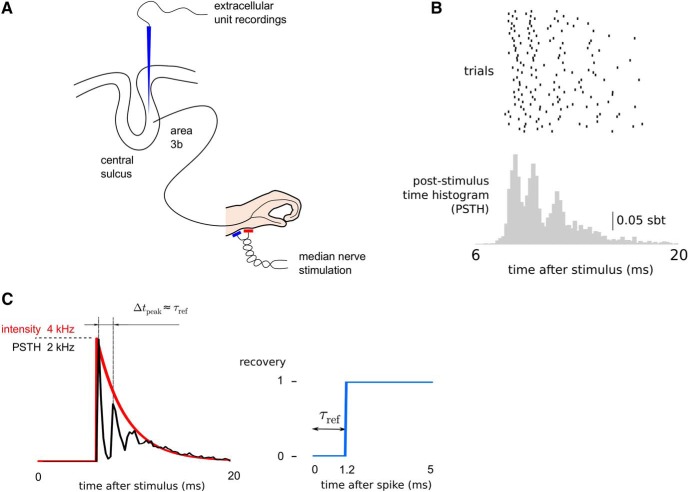
Modeling responses to median nerves stimulation of neurons recorded in S1 of macaque monkeys. A, Sketch of the experimental paradigm. B, Raster plot of 60-sample responses of a single neuron (top) and the PSTH calculated from all 956 trials (bottom; sbt, spikes per bin per trial, bin size 0.2 ms). C, Simulation of the STPM with sample parameters: exponentially decaying intensity function (left, red line) and recovery function implementing an absolute refractory period of τref = 1.2 ms (right). The simulated PSTH (left, black line) contains characteristic peaks separated by intervals Δtpeak approximately equal to τref (left, thin vertical black lines). Note the similarity to the PSTH calculated from spikes of cortical neurons triggered by the median nerve stimulation (compare with B, bottom panel).